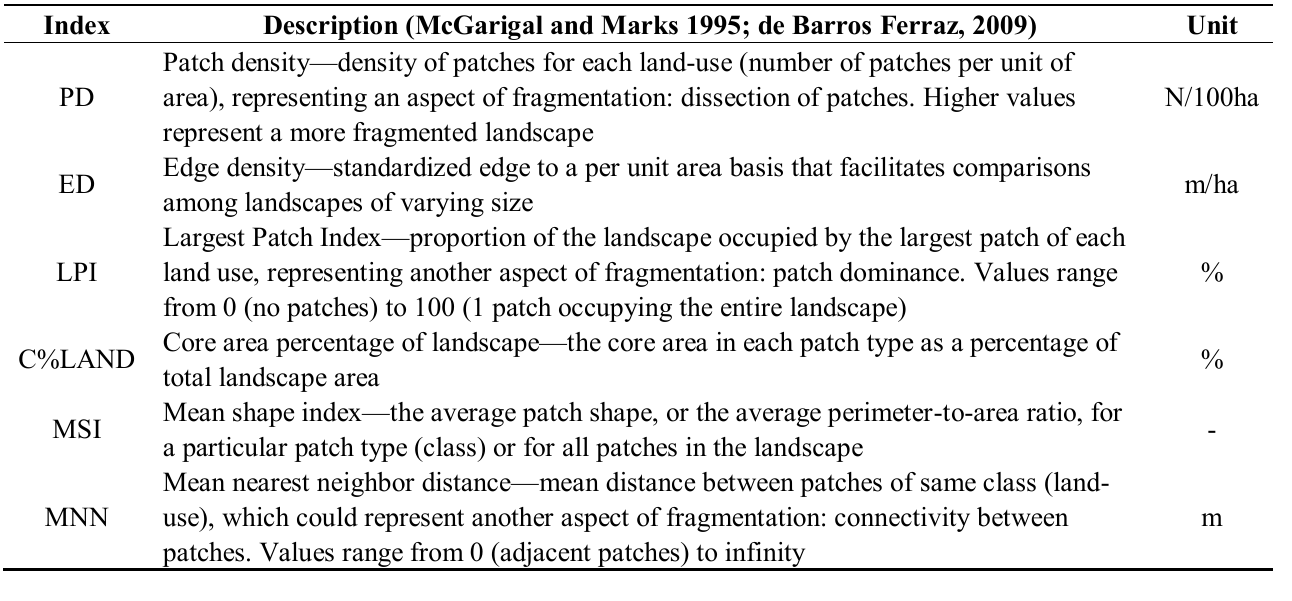
Table 1. Landscape Pattern Metrics computed in